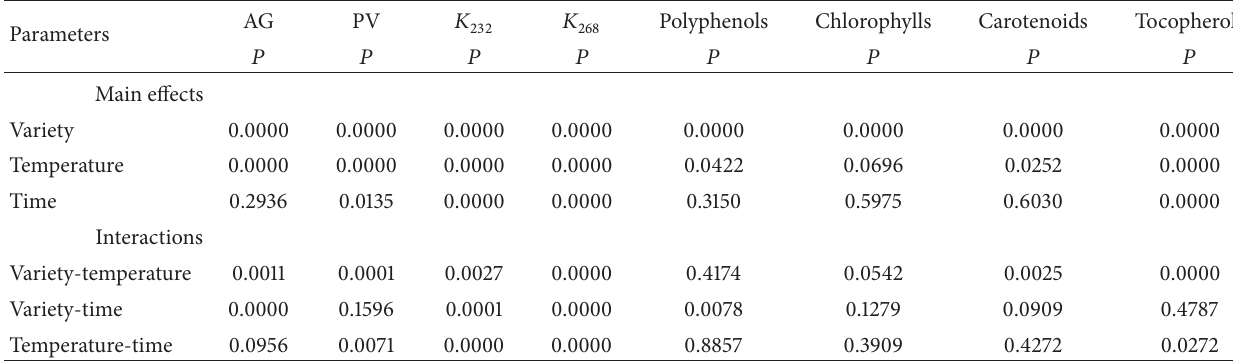
Table 3: Analysis of variance